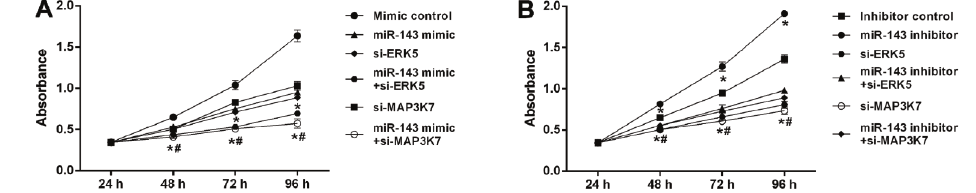
Figure 3. MTTcell viability assay for A , cells transfected with mimic control, si-ERK5, si-MAP3K7, miR-143 mimic alone or accompanied by si-ERK5 or si-MAP3K7 and B , cells transfected with inhibitor control, si-ERK5, si-MAP3K7, miR-143 inhibitor alone or accompanied by si-ERK5 or si-MAP3K7. ERK5: extracellular signal-regulated kinase 5; MAP3K7: mitogen-activated protein 3 kinase 7; si: small interfering RNA targeting. Data are reported as means ± SD of three independent experiments. *P o 0.05 compared with mimic or inhibitor control, # P o 0.05 compared with miR-143 mimic or inhibitor